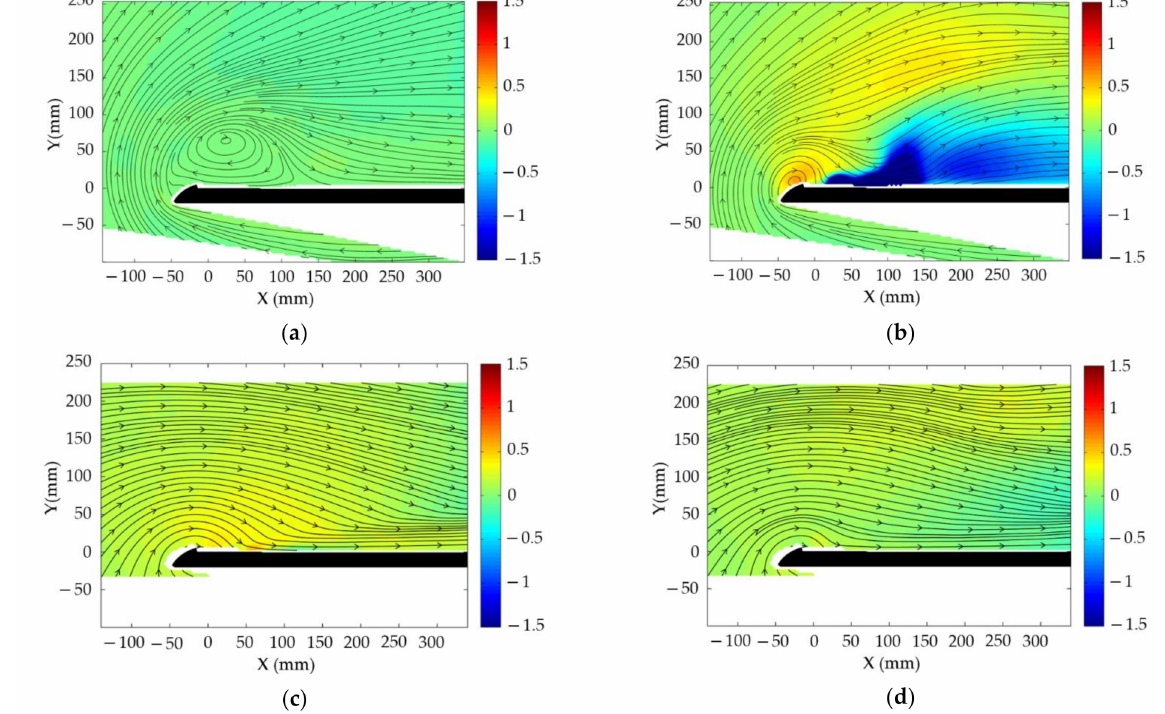
Figure 25. Flow in the area of side post and side wall. Diagrams with sectional streamlines of the mean flow field in the horizontal measuring level and contours of the velocity magnitude in Z-direction normalized by the mean inflow velocity: . S = 48 m 3 /h, C µ = 2.25; ( c ) fume hood with improved nozzles ( a ) fume hood with no flow control; ( b ) baseline fume hood, . . S = 14.1 m 3 /h, C µ = 1.78; and ( d ) Fume hood with oscillators, S = 6.8 m 3 /h, C µ = (steady outflow),